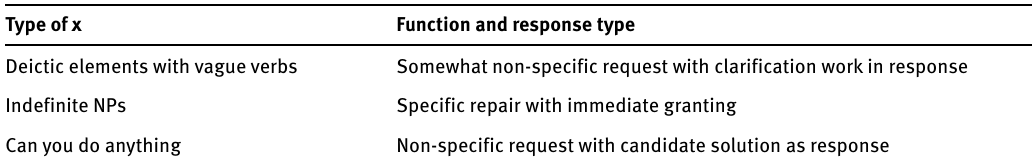
Table 1. Types of x in ‘can you’ requests Type of